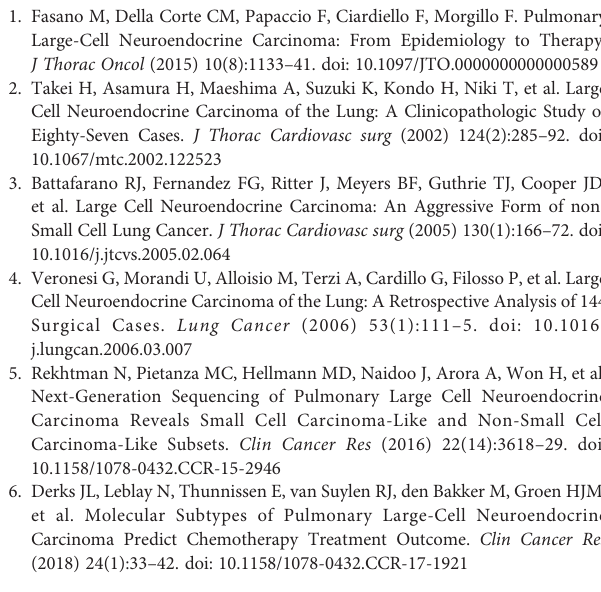
Supplementary Figure 2 | Schematic diagram illustrating work fl ow for ALK diagnostics per IHC, FISH and NGS in the retrospective cohort. IHC was assessed fi rst on all evaluable samples (n=365/439). FISH was scored on 28 samples positive by ALK IHC. NGS was performed on 12 samples positive per IHC and with enough available material. ALK, anaplastic lymphoma kinase; IHC, immunohistochemistry, FISH, fl uorescence in situ hybridization; NGS, next-generation sequencing. Supplementary Figure 3 | Schematic diagram illustrating work fl ow for ALK diagnostics per IHC, FISH and NGS in 3 index cases. IHC was assessed and was evaluated as positive (3+) on all 3 samples (n=3/3). FISH was scored and resulted positive on 2/2 evaluable samples. NGS con fi rmed ALK rearrangement in all